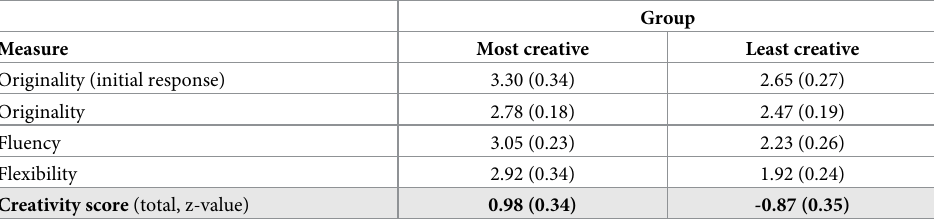
Table 1. Mean (SD) response scores for the soccer-specific tactical creativity test across